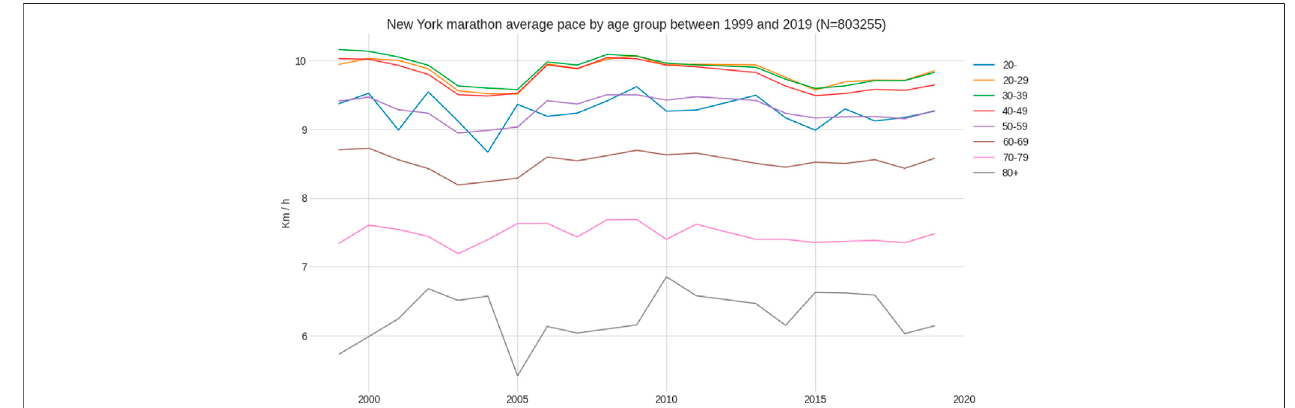
FIGURE 4 | Average running speed by age group between 1999 and 2019.